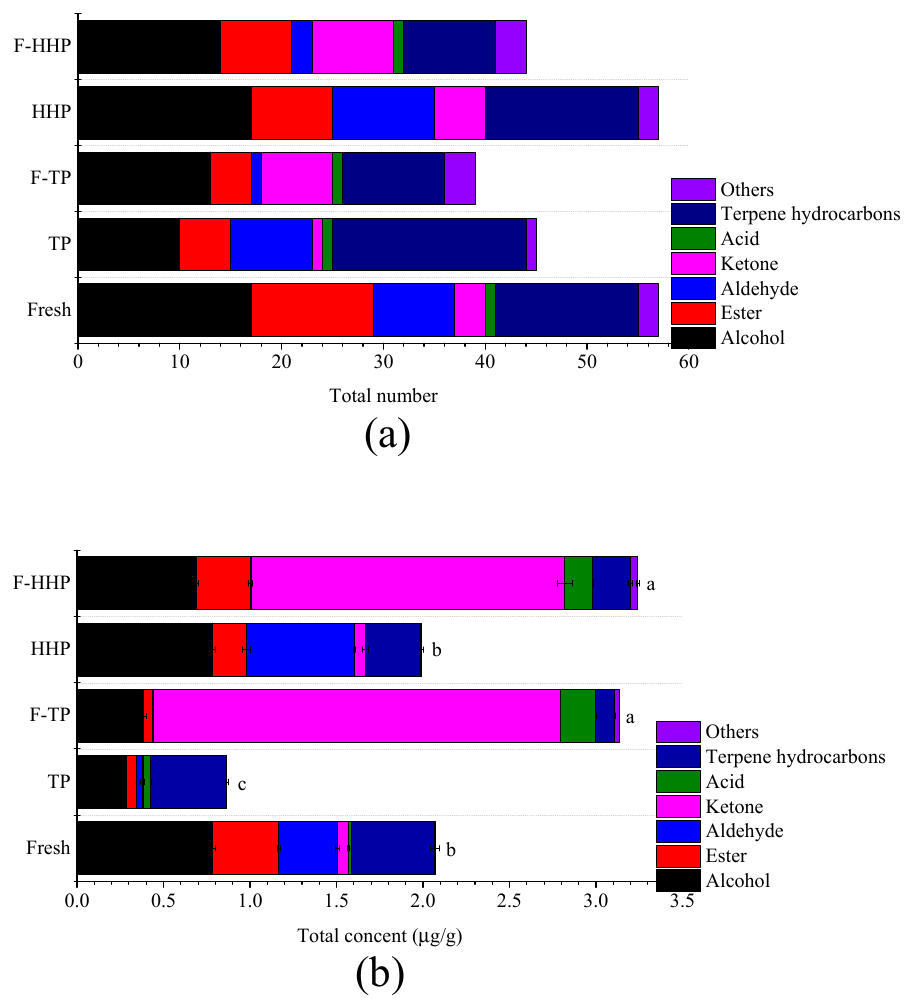
Figure 3. ( a ) Total number and ( b ) content of different volatile flavor compounds in different treated yacon-litchi-longan (YLL) juice. Different letters represented a signi fi cant difference within the same row ( p < 0.05).